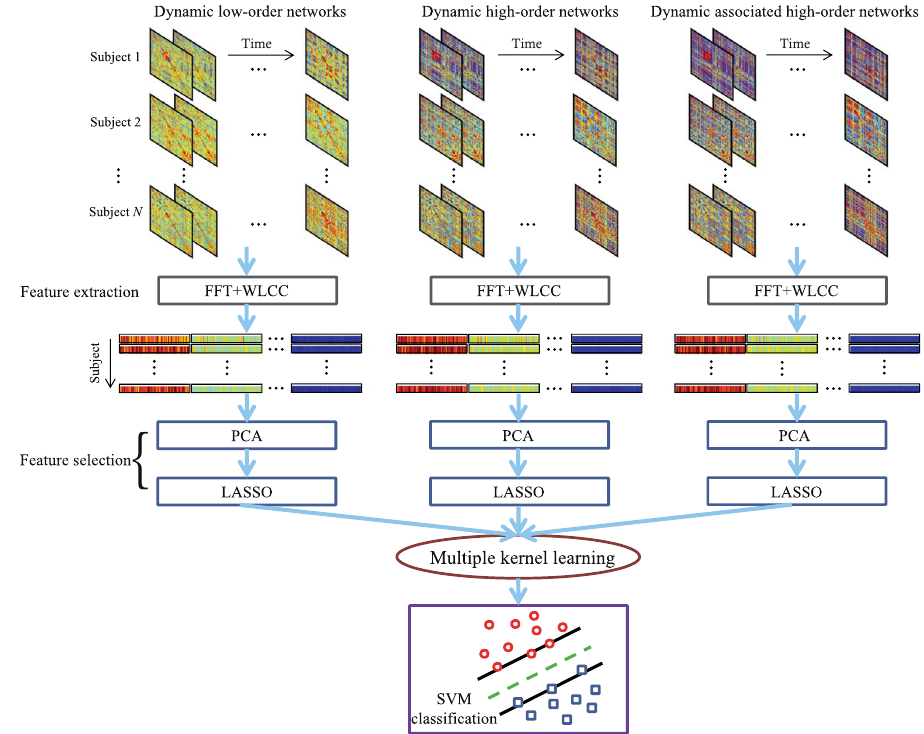
Figure 11. Our proposed eMCI diagnosis framework based on hybrid high-order FC networks. It has the three types of dynamic FC networks as input; after feature extraction and selection, a multiple kernel learning strategy is used to achieve effective feature fusion for classification. (FFT: Fast Fourier transform, WLCC: Weighted local clustering coefficient, PCA: Principal component analysis, LASSO: Least absolute shrinkage and selection operation, SVM: Support vector